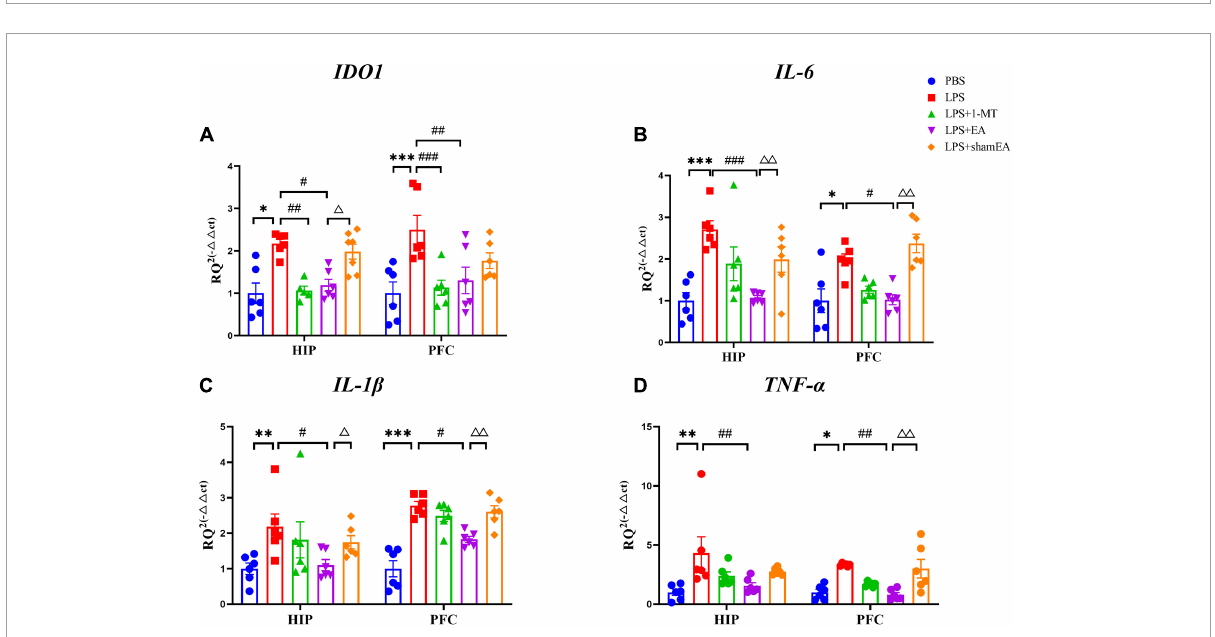
FIGURE4 Effects of EA have been observed in the hippocampi and prefrontal cortex of mice, which were upregulated by LPS. Mouse HIP and PFC were collected after behavior testing and tested for mRNA levels of (A) IDO1, (B) IL-6, (C) IL-1 β , and (D) TNF α using quantitative PCR. The results are expressed as the mean ± SEM ( n = 8 per group. ∗ p < 0.05, ∗∗ p < 0.01, ∗∗∗ p < 0.001, compared with the saline group; # p < 0.05, ## p < 0.01, ### p < 0.001, compared with the LPS group; (cid:49) p < 0.05, (cid:49)(cid:49) p < 0.01, compared with the sham EA group).